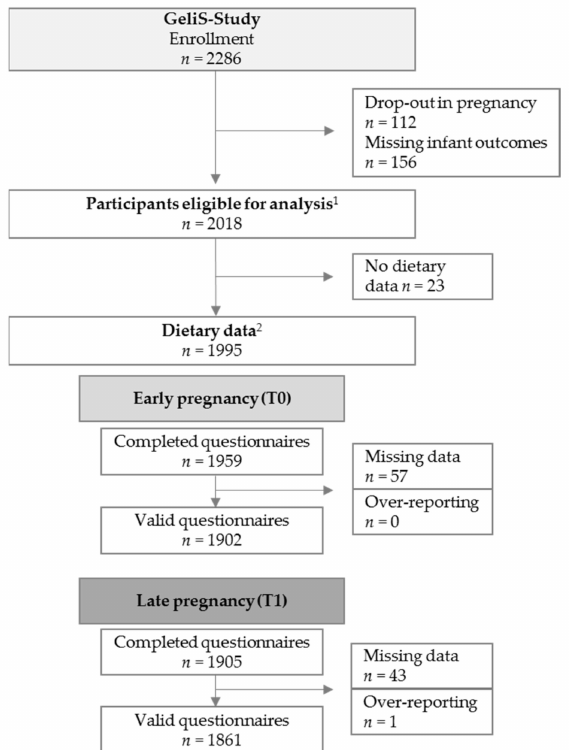
Figure 1. Participant flow. 1 Women without miscarriages, late loss of pregnancy, terminations, pregnancy complications that interfered with the intervention, maternal deaths and / or lack of infant outcomes (birth weight, birth length). 2 Women who provided dietary data at T0 or T1. T0: